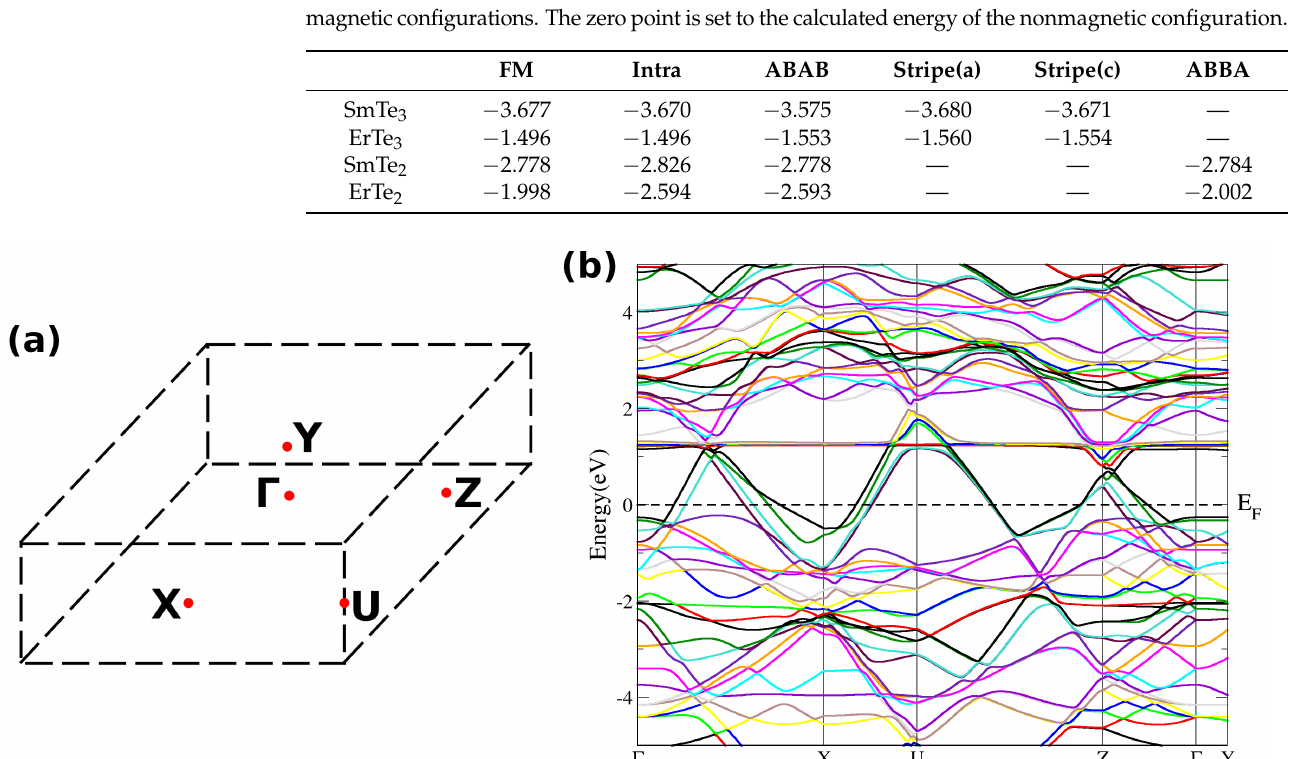
Figure 4. ( a ) The 3d Brillouin zone of AFM stripe ErTe 3 , with high symmetry points labeled. Γ is at the center of the Brillouin zone, and Y is at the center of the top face. ( b ) The energy bands of spin-up electrons in stripe antiferromagnetic ErTe 3 , plotted along high symmetry directions in the Brillouin zone. Because ErTe 3 is AFM, the band structure plot for spin-down electrons is indistinguishable from the plot for spin-up electrons. The Fermi energy is set equal to zero and is shown as a dashed horizontal line. The colors of the bands have no significance; they are used only to make the figure